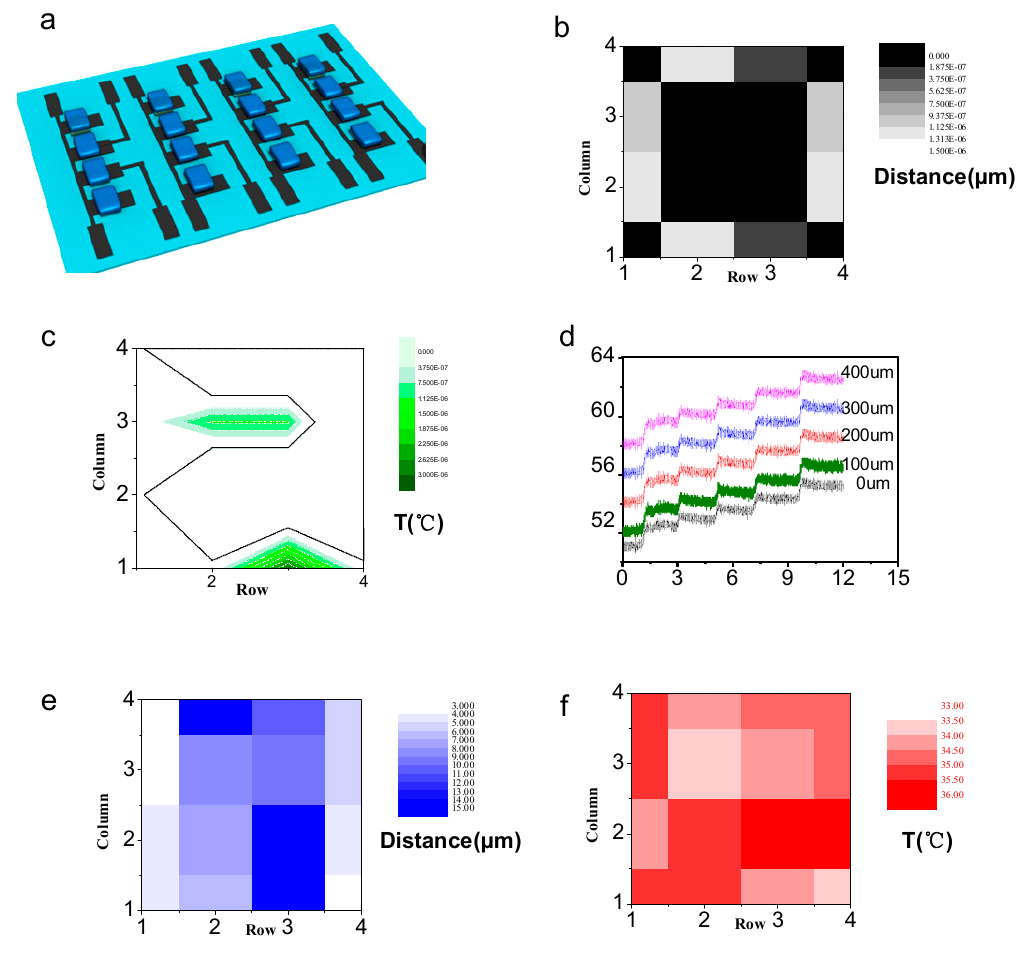
Figure 5. Characterization of GSFET noncontact mechanosensation active matrix. ( a ) Schematic illustration of the mechanosensation matrix for sensing the distance information and temperature. ( b ) 2D mapping of the distance sensing output currents for the matrix. ( c ) 2D mapping of the temperature sensing output currents for the matrix. ( d ) The real-time temperature monitoring and distance monitoring between the ion gel and skin. ( e ) 2D mapping of the distance sensing output currents for the matrix as the device is attached onto the human’s knee joint and conforms to it. ( f ) 2D mapping of the temperature-sensing output currents for the matrix as the device is attached onto the human’s knee joint and conforms to it.